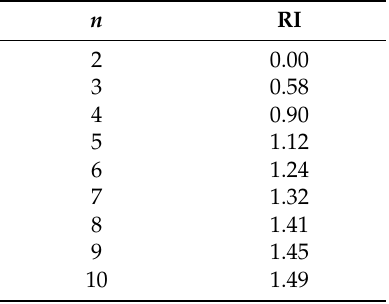
Table 2. Empirical Values of the Random Consistency